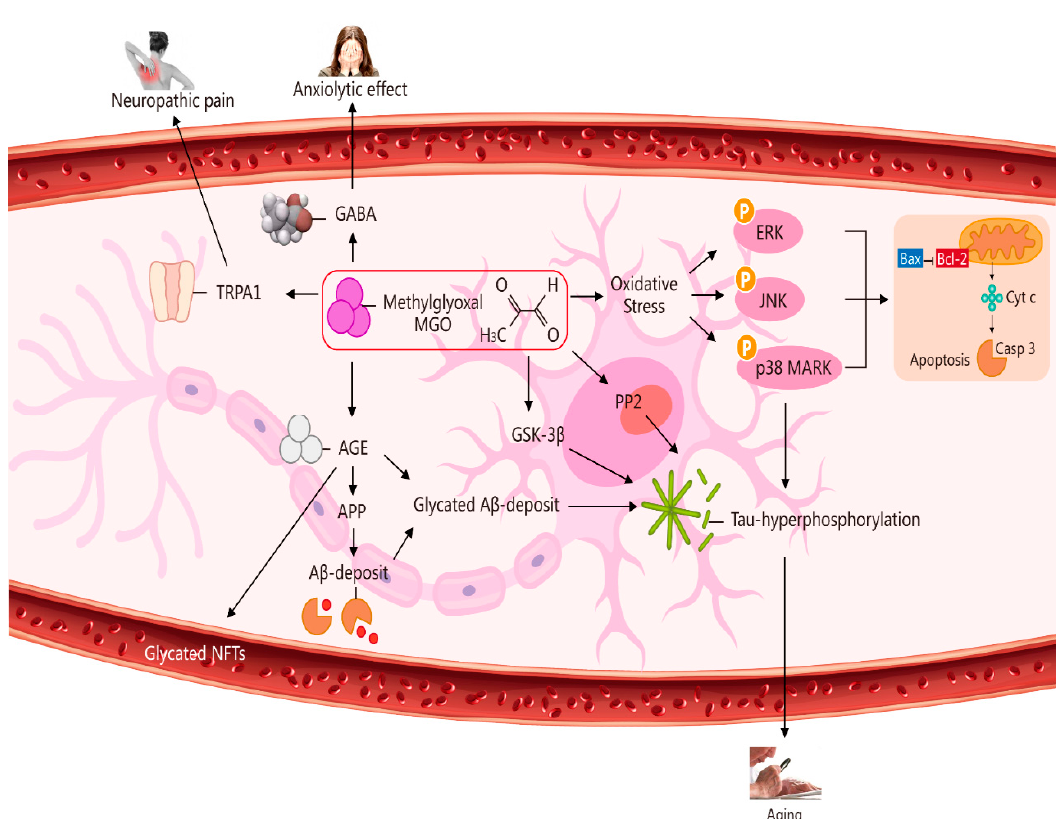
Figure 2. Multiple pathways via which MGO induces oxidative stress, pain, anxiolytic effects, and ageing. The pathways activated by MGO induce oxidative stress, which may play a role in ageing. The formation of AGEs involves nonenzymatic reactions that occur when sugars or dicarbonyl compounds, such as MGO, are reduced. Research has been conducted on the connection between neuropathic pain and the transient receptor potential ankyrin 1 ( TRPA1 ) pathway. MGO mediates the anxiolytic effect via the modulation of GABAergic actions. MGO mediates ERK-, JNK-, and p38-dependent endothelial cell inflammatory responses, which may occur independently of oxidative stress. In addition, BCL2-associated X protein (BAX) accesses mitochondria to induce cytochrome c release, and Bcl-2 inhibits BAX translocation from cytosol to mitochondria during relevant apoptosis. MGO induces the expression of phosphorylated tau protein and increases the expression of protein phosphatase 2A (PP2A) and glycogen synthase kinase-3 β (GSK-3 β ). A reduction in A β deposition can eventually improve learning and memory ability. AGE interaction with the receptor for AGEs (RAGE) carries an implication for AD. Glycated A β (A β -AGE) can aggravate an AD-like pathology via the receptor for the RAGE pathway. MGO increases intracellular calcium in sensory neurons and produces neuropathic pain via the cation TRPA1 channel.